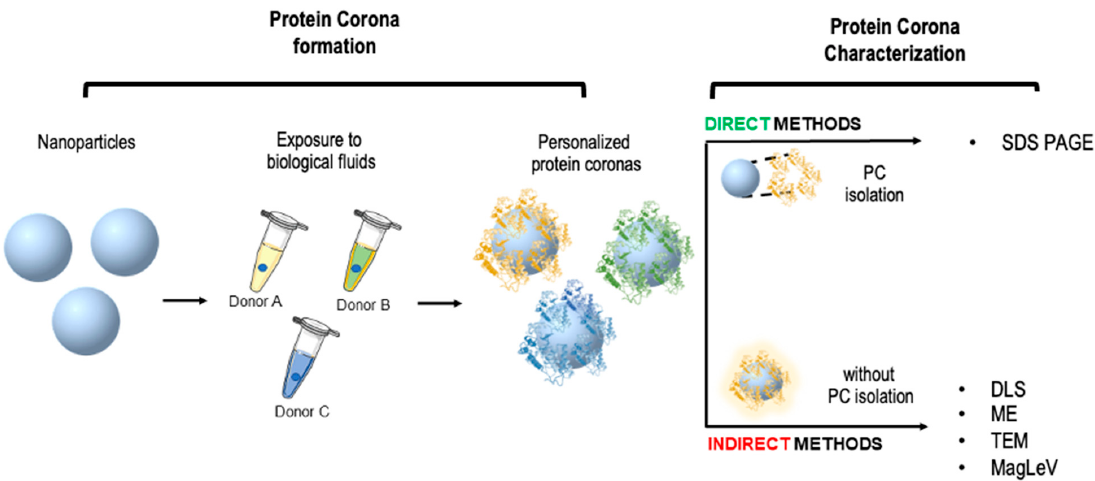
Figure 3. Schematic representation of nanoparticle-enabled blood (NEB) test for personalized PC characterization. Nanoparticles are exposed to biological fluids from different donors giving rise to personalized protein coronas. Direct methods of corona characterization require protein isolation from the particle surface, while indirect methods characterize the whole nanoparticle-corona